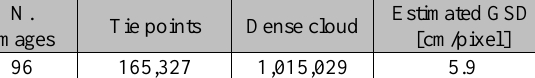
Table 8. Main details of the photogrammetric process (thermal dataset).